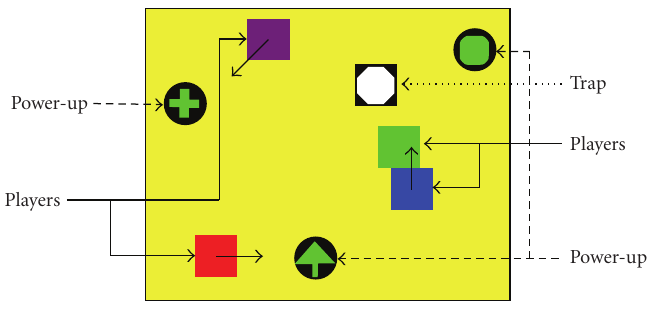
Figure 1: Illustration of the BrickBlock game.